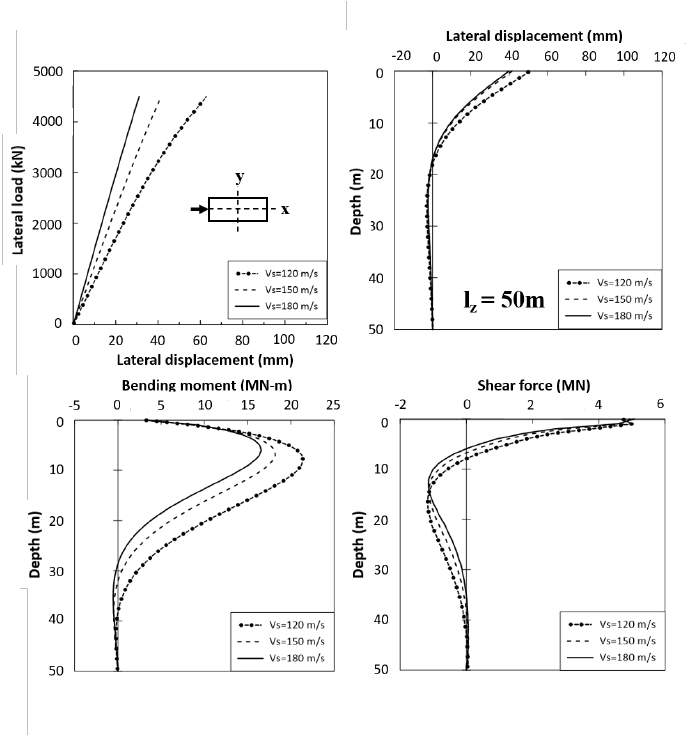
Fig. 9. Performance of 50m barrette in clays with load applied in longitudinal direction